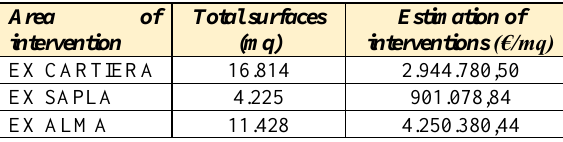
Table 4. General estimate of the economic impact on each